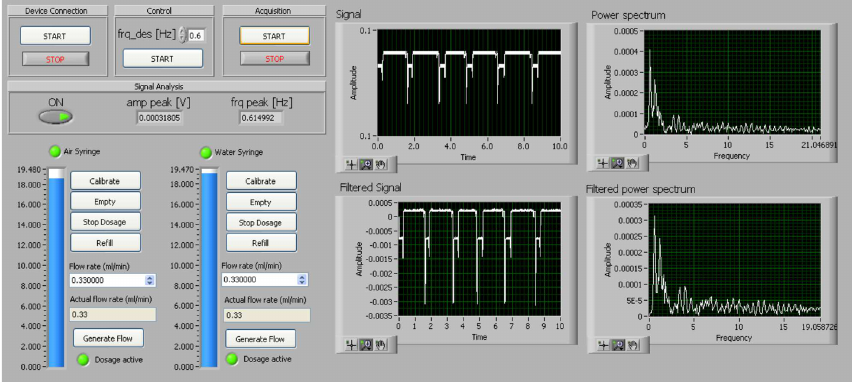
Figure 8. The GUI of the platform. It consists of a section related to the pumps control (on the left ) and a section to monitor in real time the raw and the filtered signals and spectra (on the right ).